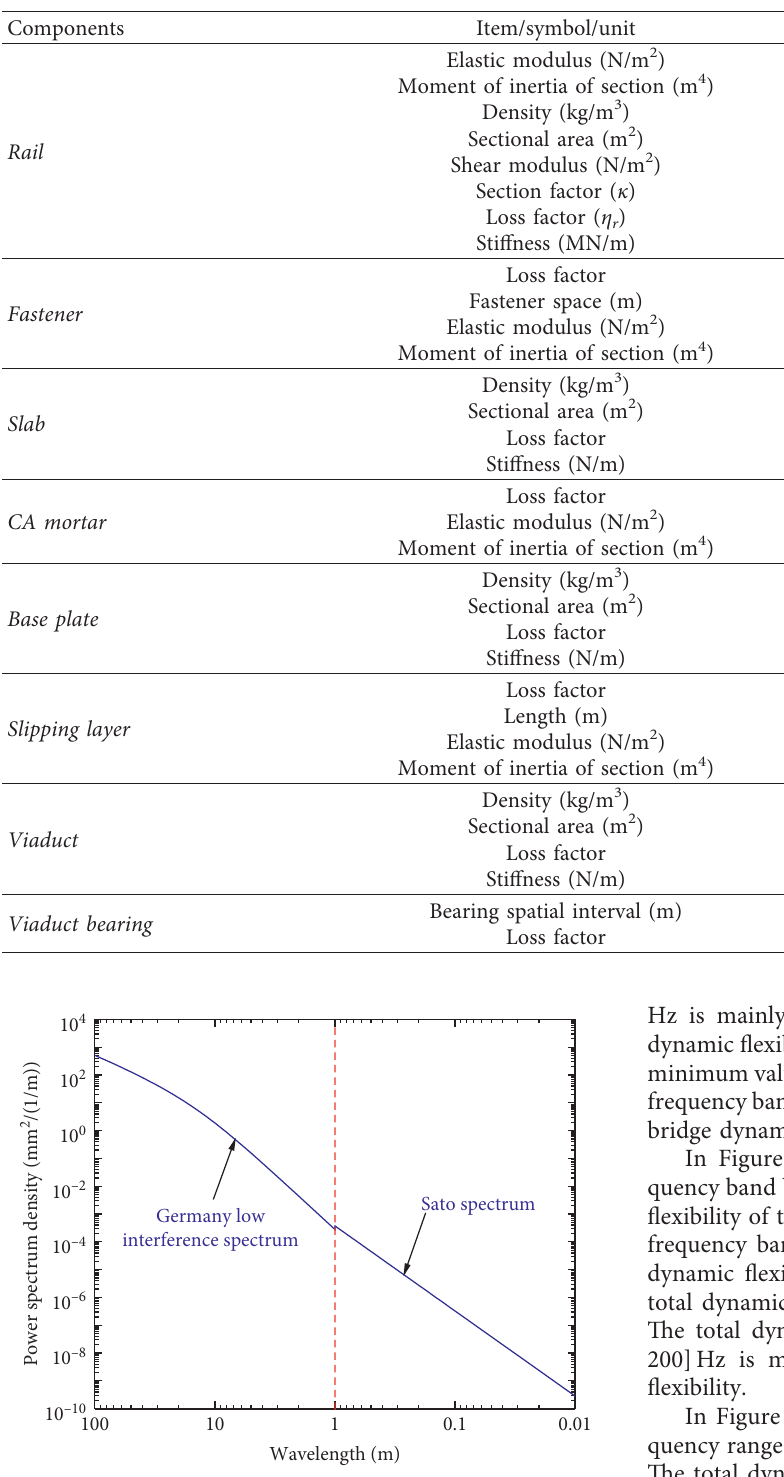
Table 3: Dynamic parameters of track-bridge structure.